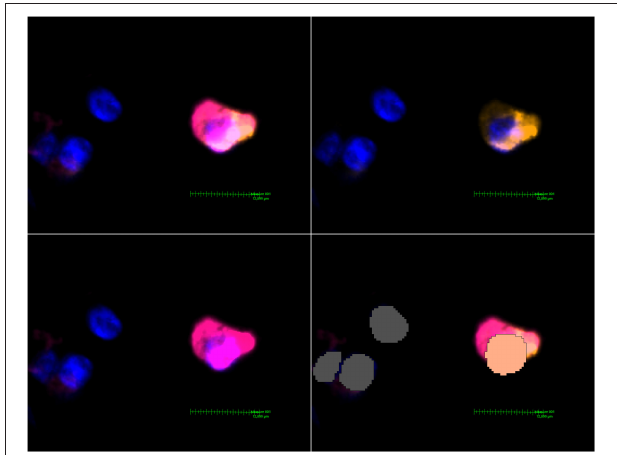
FIGURE 2 | MHC class II expressing mDC found in a non-DAD lung lobe. Upper left image: Activated Channels: DAPI, Cy5 (orange, CD11c stain) and Cy7 (MHC class II stain). The comparatively weak CD11c signal can be seen alone in the upper right image. The lower left image shows Cy7 and proves a massive upregulation of MHC class II in this particular dendritic cell. The lower right image shows the interpretation by Visiopharm AI. A salmon pink mask marks a CD11c + MHC II + cell. Grey: Other cells (negative or below a certain threshold for markers but with a detectable nucleus in the DAPI channel).